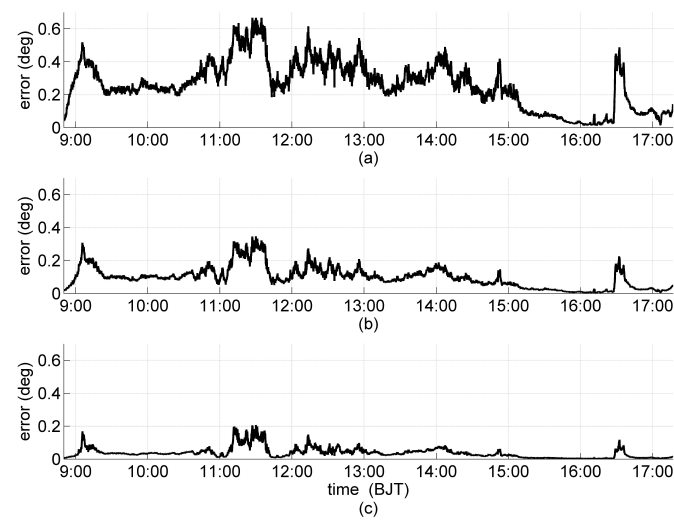
Figure 9. Difference of the average orientation error of orientation matrices that have the same κ and the matrix 15 whose κ = 0.8 is the smallest: ( a ) κ = 1.59 and κ = 0.8; ( b ) κ = 1.12 and κ = 0.8; and ( c ) κ = 0.92 and κ =